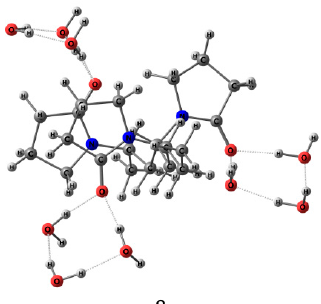
Figure 8. Optimized geometry of the VP-VP-VP ∙ 9H 2 O in structure 8 with the trans -conformation of VP units.